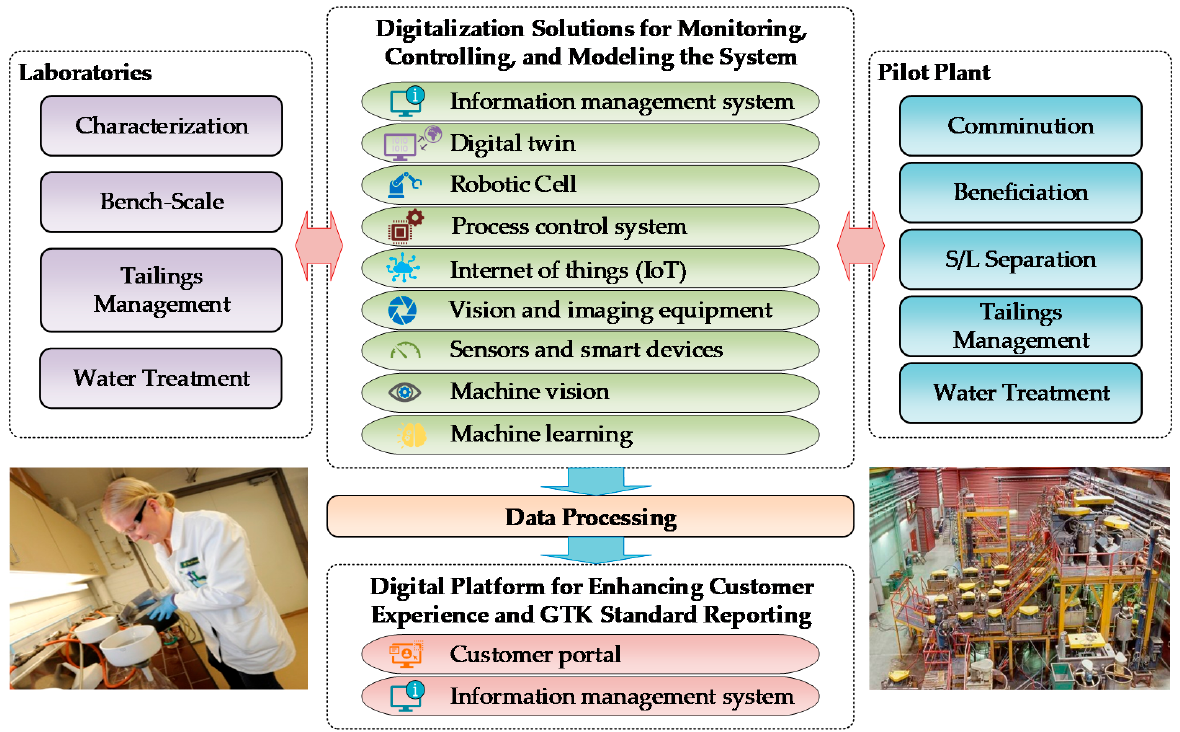
Figure 3. GTK Mintec platform and main data streams after the digitalization.